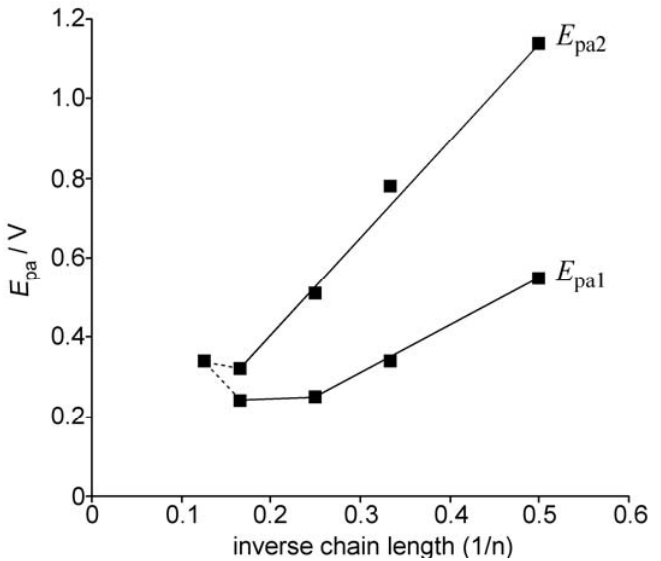
Figure 4. Correlation of the first ( E oligothiophene 1 (nT) (n = 2, 3, 4, 6) and 2 (8T) with the inverse chain length